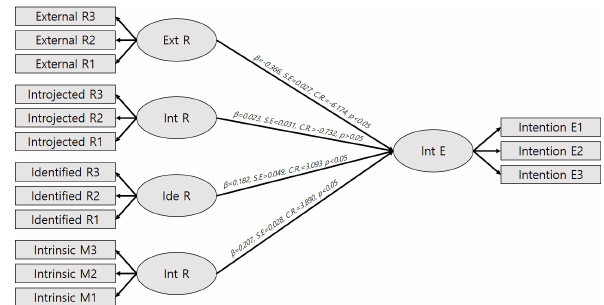
Fig. 3. Result of the structural